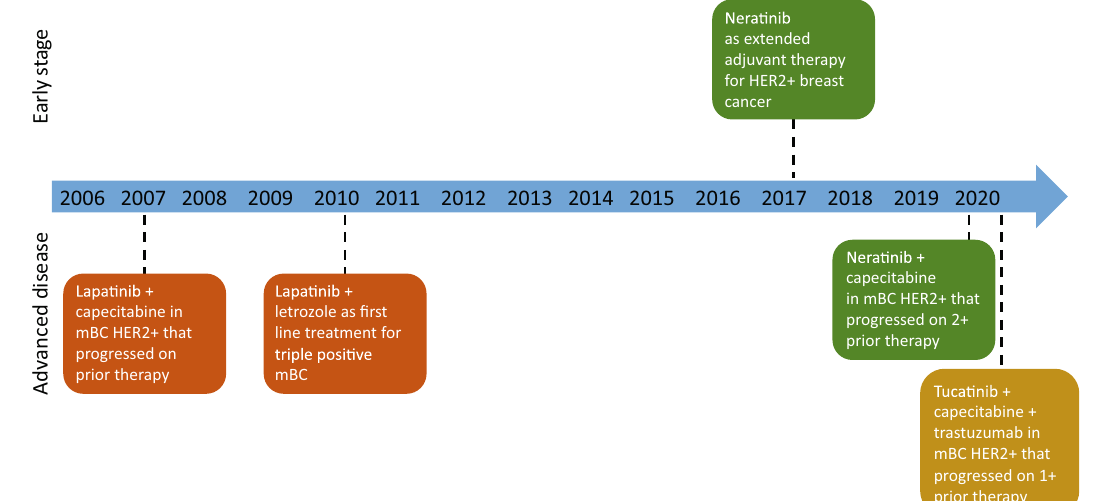
Fig. 2 United States Food and Drug Administration and Approval History of HER2-targeted tyrosine kinase inhibitors. This shows the time of approval and indications of the currently tyrosine kinase inhibitors approved by the United States Food and Drug